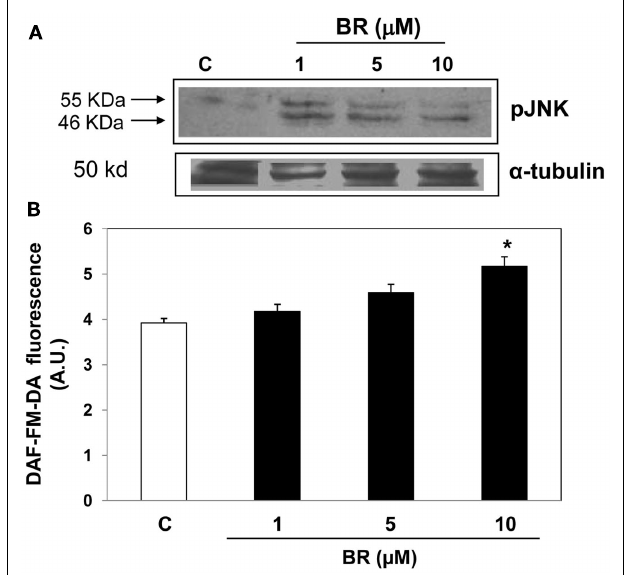
FIGURE 5 | Effect of bilirubin (BR) on cellular expression of the c-Jun N-terminal kinase (JNK) and nitric oxide (NO) production. Hep-2 and Vero cells were pre-incubated with BR (1–10 μ M) for 2h. At the end of incubation, BR was removed, the Hep-2 cells lysed and assayed for JNK phosphorylation byWestern Blot (A) as described under the Section “Materials and Methods.” α -tubulin was used as housekeeping gene to verify protein equal loading. On the contrary,Vero cells were assayed for NO production by using the fluorescent probe DAF-FM-diacetate [DAF-FM-DA, (B) ] as described under the Section “Materials and Methods.” (A) Shows a representative gel. In (B) , data are expressed as DAF-FM-DA fluorescence arbitrary units (A.U), mean ± SEM of six individual samples per group. * P < 0.05 versus control